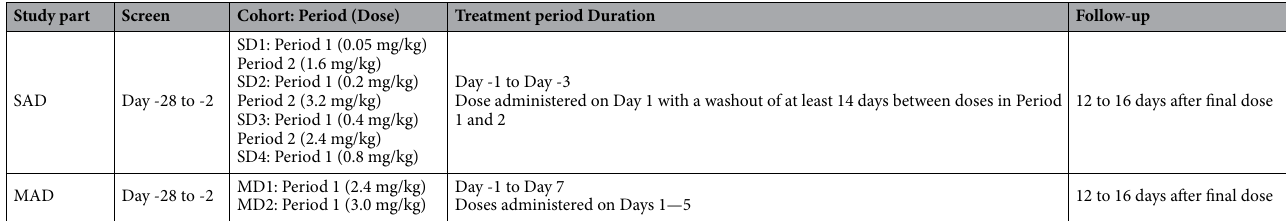
Table 6. Summary of study design. SD: Study